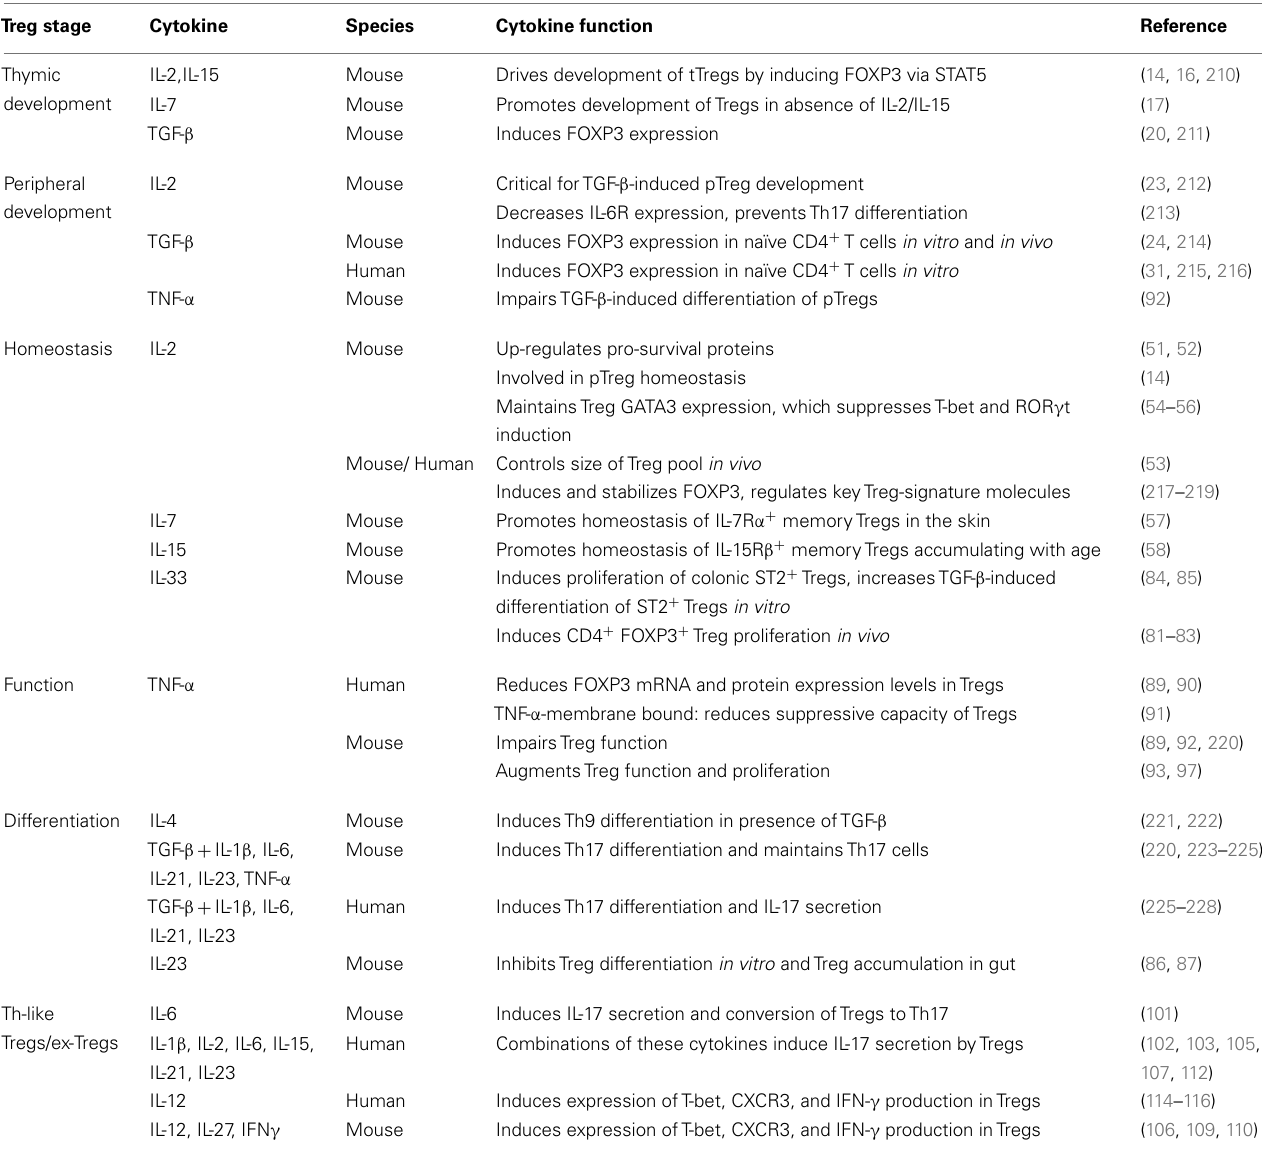
Table 1 | Summary of cytokines that influenceTregs